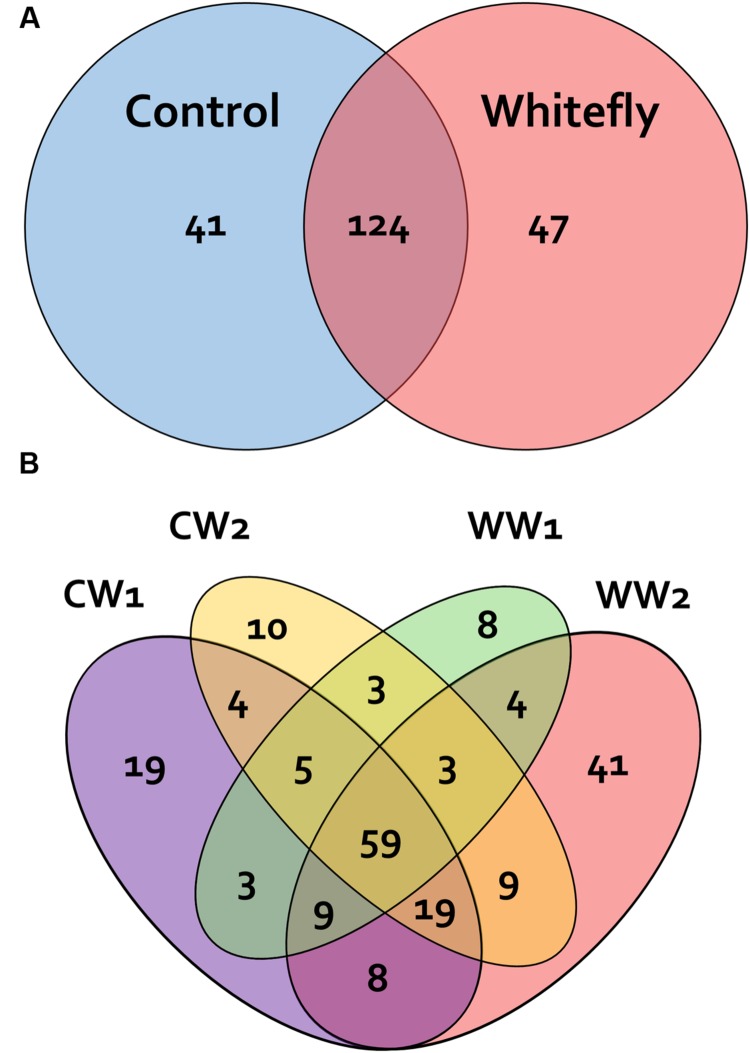
Venn diagrams representing the number of unique and shared operational taxonomic units (OTUs 97% sequence similarity). Diagrams comparing pyrosequencing results from the control and whitefly-infested pepper plant rhizosphere (A) and after different durations of whitefly infestation and the control (B). OTUs are defined at 97% sequence similarity. The relative abundance of shared OTUs across all samples is shown in parentheses.